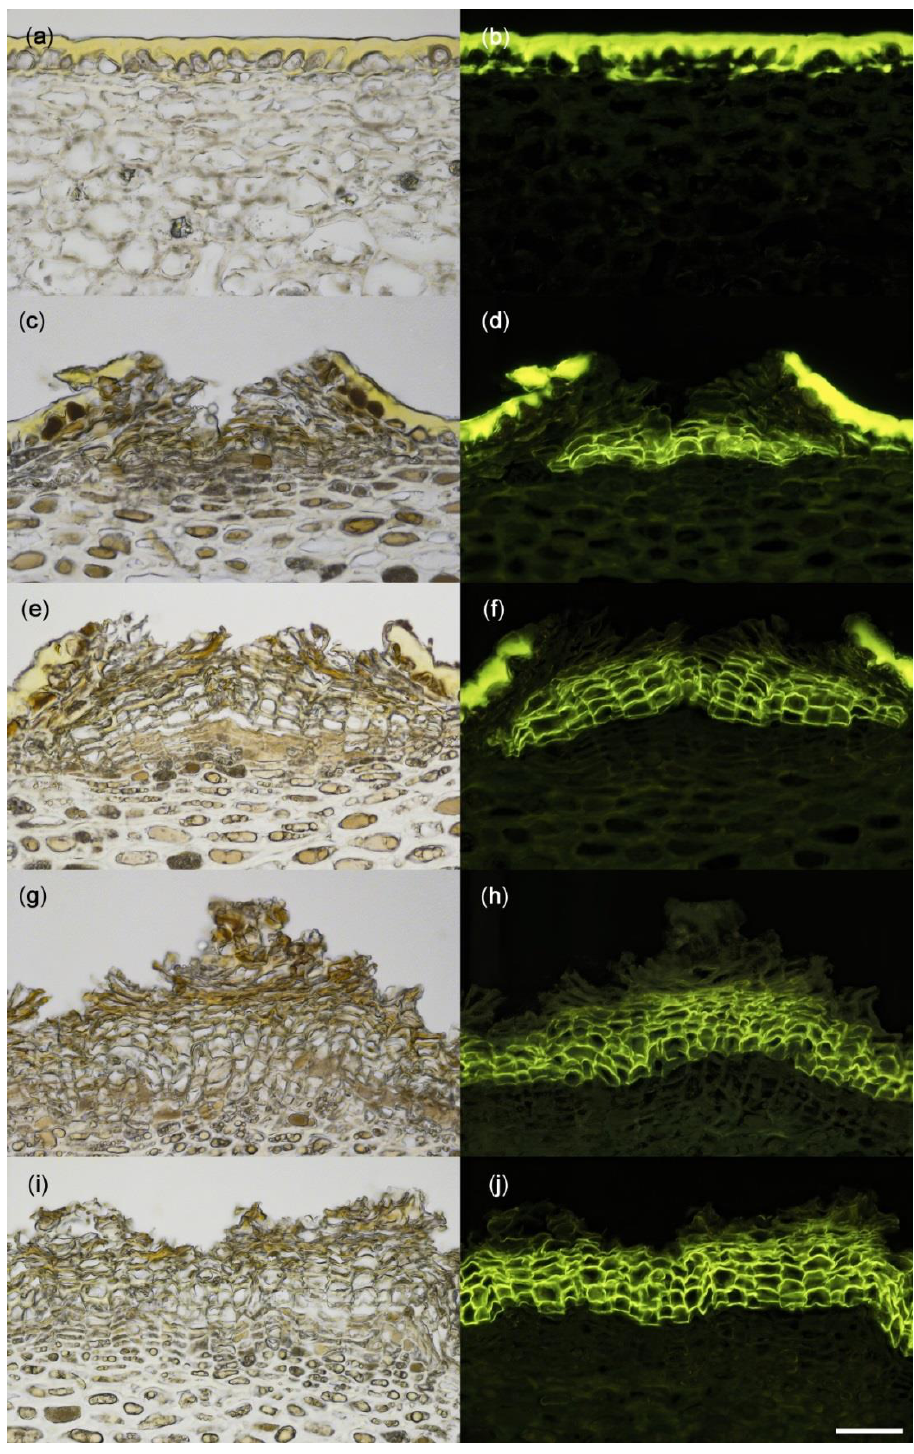
Figure 4. Cross-sectional microscope images of a non-russeted ( a,b ) and russeted ( c – j ) skin of ‘Apple’ mango viewed under incident white ( a,c,e,g,i ) or fluorescent light ( b,d,f,h,j ) following staining with fluorol yellow dye. Scale bar is 50 µm.